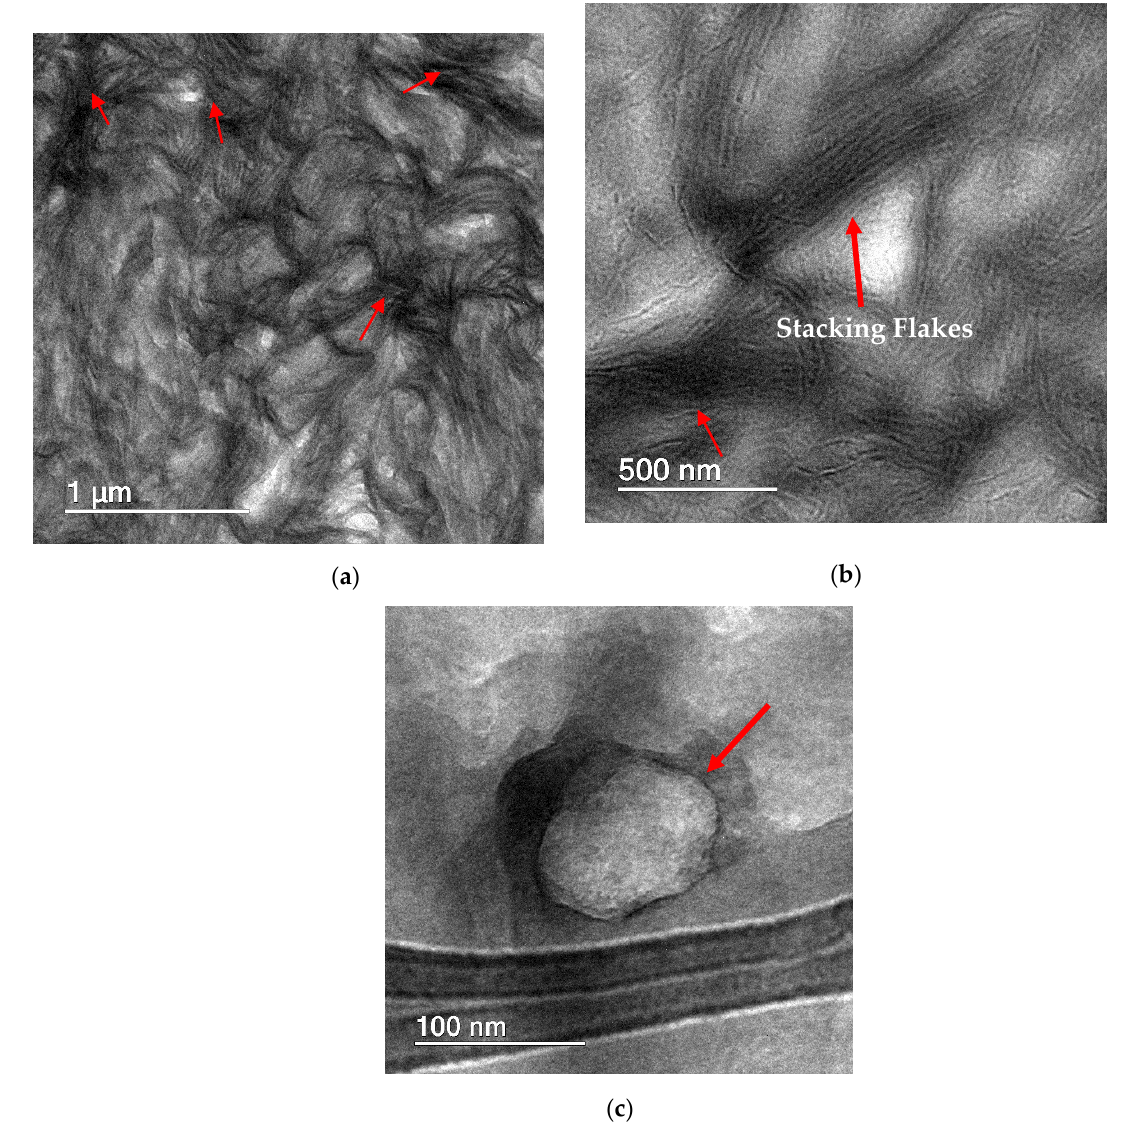
Figure 2. TEM images of agglomerated mGO ( a , b ) and nonagglomerated mGO ( c ) contained in the HMWPE. Table 1. Values of mechanical properties of the nanocomposites obtained from tensile test. Samples mGO